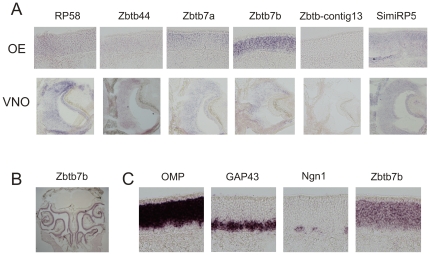
Expression pattern of the BTB-ZF genes in the olfactory and vomeronasal epithelia.(A) Coronal sections through the olfactory epithelium (OE) or vomeronasal epithelium (VNO) were hybridized with antisense digoxigenin-labeled probes specific for Zbtb7b, Zbtb-contig13, Zbtb44, Zbtb7a, RP58 or simiRP58 as indicated. Corresponding sense digoxigenin-labeled probes were used as negative controls (not shown). B) Zbtb7b is expressed throughout the olfactory epithelium. C) Zbtb7b is expressed in the neuronal layers of the olfactory epithelium (mature and immature neurons). OMP, GAP43 and Ngn1, used as a control, are respectively expressed in mature olfactory neurons, immature olfactory neurons and neuronal progenitors.